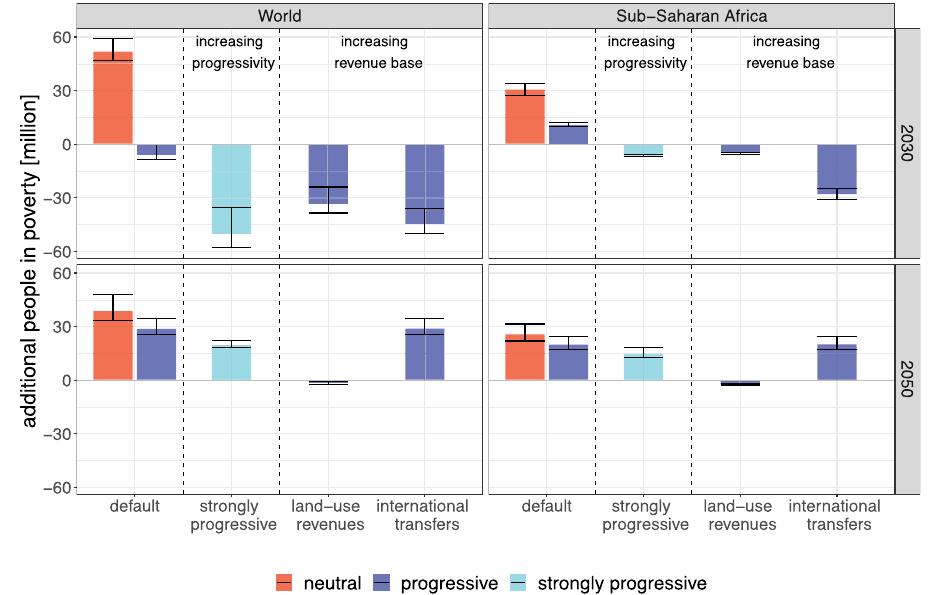
Fig. 5 Additional measures to achieve poverty co-bene fi ts (SSP2). We show three different ways to enhance the poverty reduction co-bene fi ts of the revenue recycling. The fi rst option has the same revenue base as the default case (shown at the very left for comparison), but redistributes them in a strongly progressive way. The second and third options, land-use revenues and international transfers, increase the revenue base available for redistribution. Left and right panels are global results and Sub-Saharan Africa, respectively; top and bottom panels 2030 and 2050. Bars represent the central projection, error bars are 68% prediction intervals (see also caption of Fig.